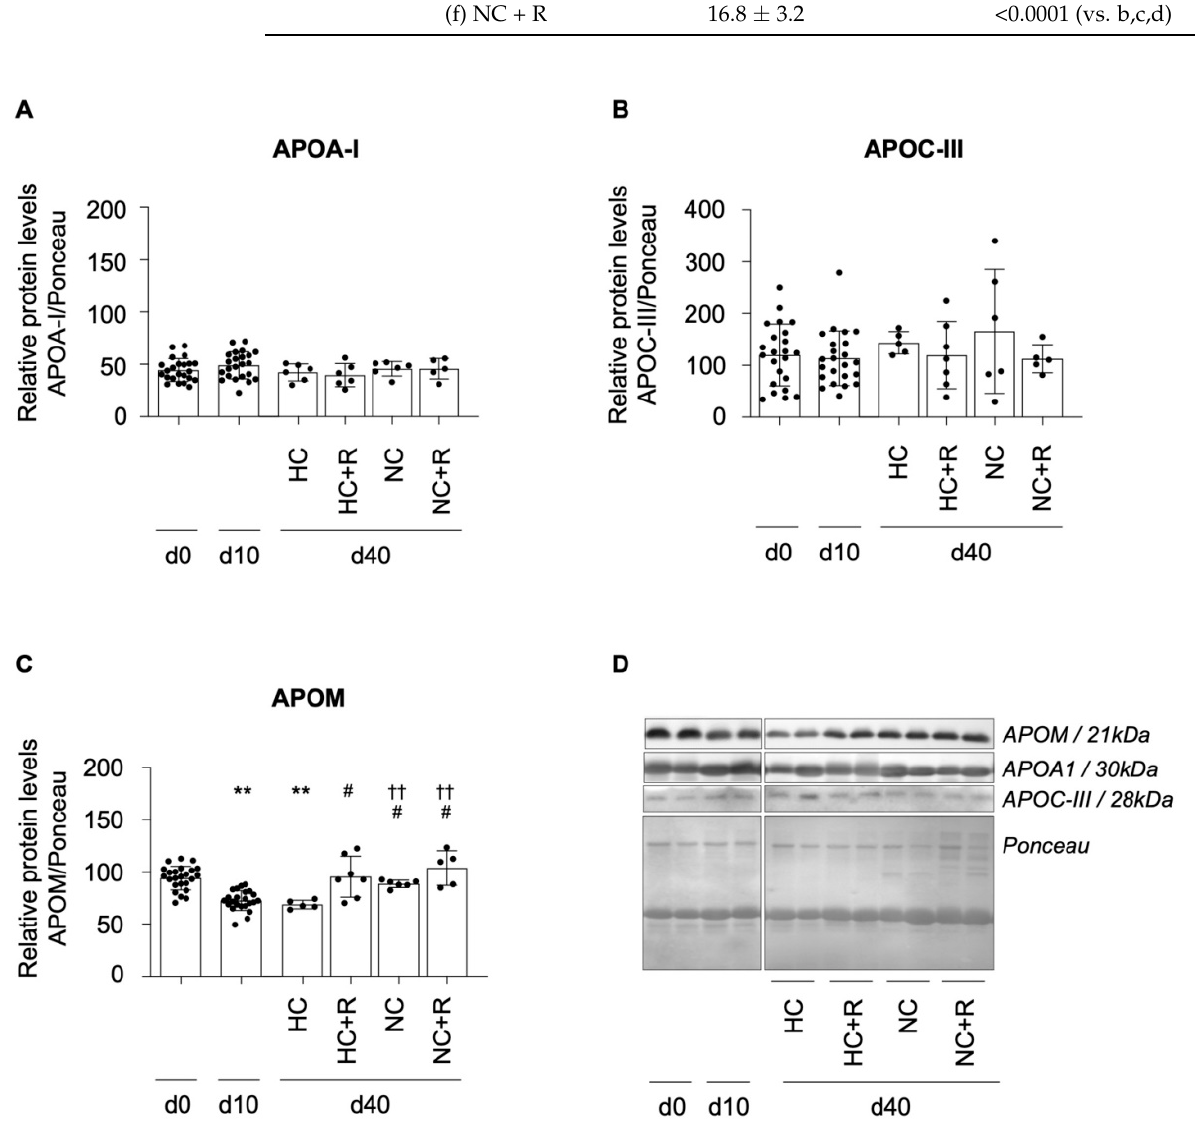
Figure 4. Effects of diet and rosuvastatin intervention on HDL apolipoprotein levels. Changes in protein levels of apolipoproteins (APO) APOA-I ( A ), APOC-III ( B ), and APOM ( C ) in isolated HDL particles are presented as relative quantification and representative Western blots ( D ) at study endpoint. Western blot quantifications are shown as mean ± SD. Shapiro–Wilk test confirmed